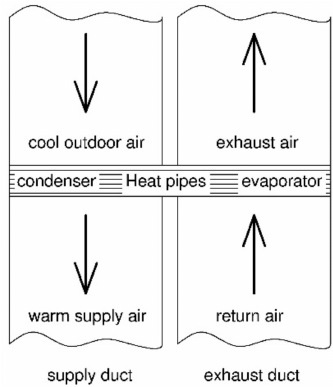
Figure 4. The use of heat pipe in heat recovery from air